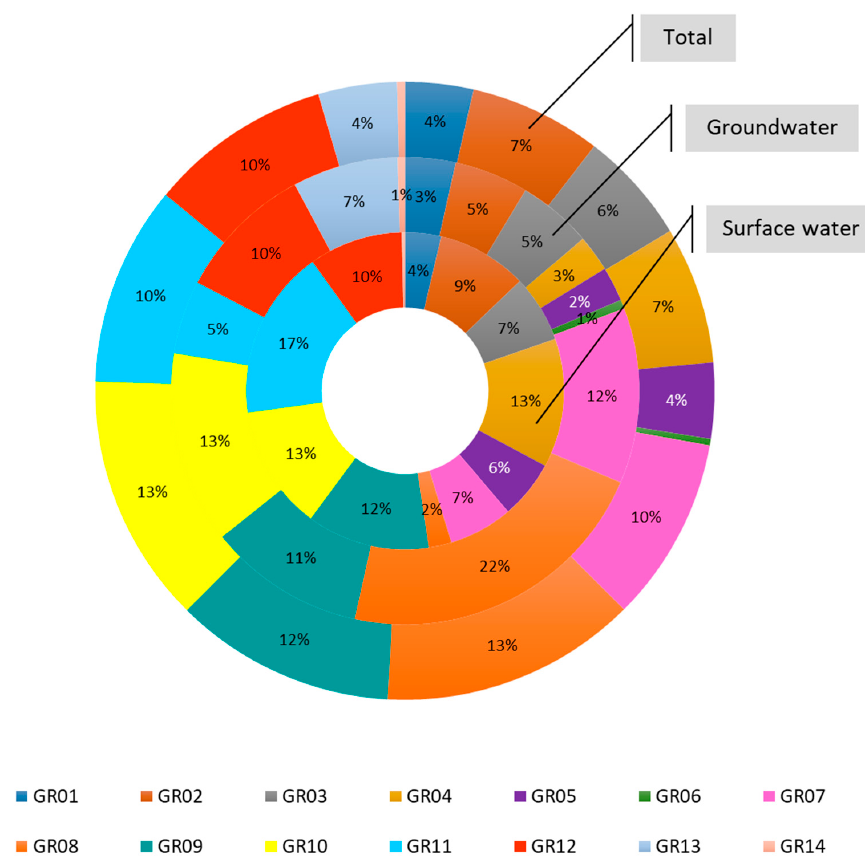
Figure 6. Distribution of agricultural water demand on Greek RBDs, with a distinction between groundwater and surface water for base year 2011.